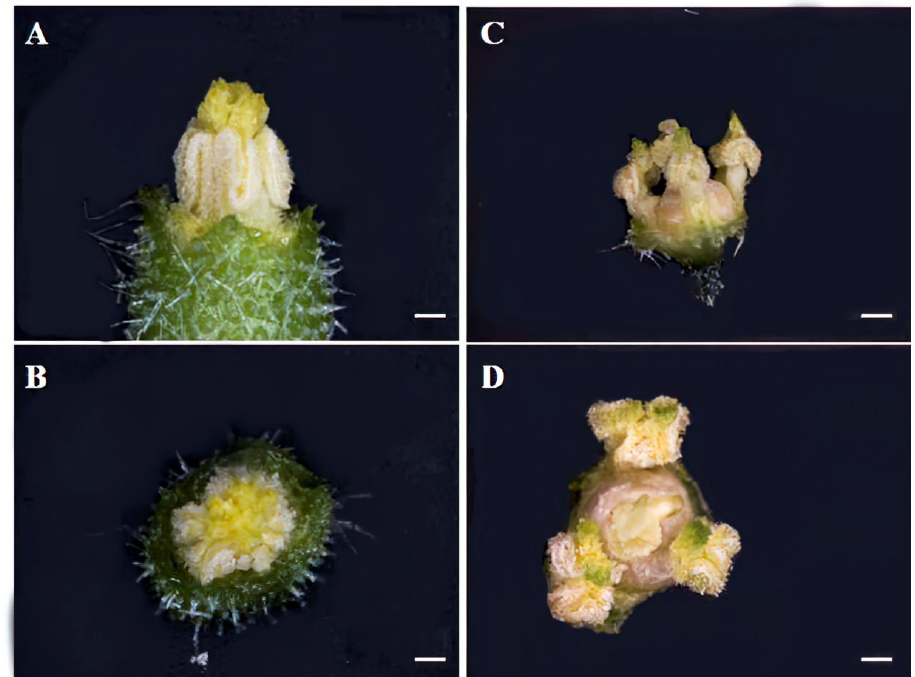
8 Figure 8. Anatomical observations of the stamen of odd1 . ( A , B ) The stamen of WT at anthesis. ( C , D ) The stamen of odd1 at anthesis. Scale bars represent 5